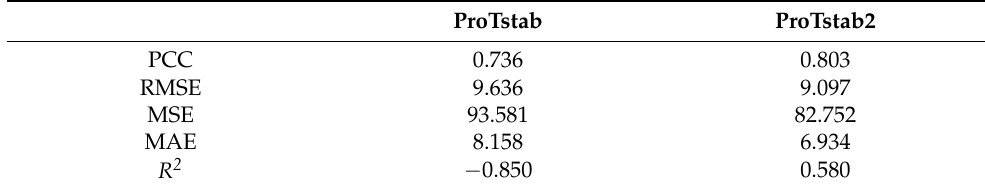
Table 5. Comparison of the performances of ProTstab and ProTstab2 on blind test data set.